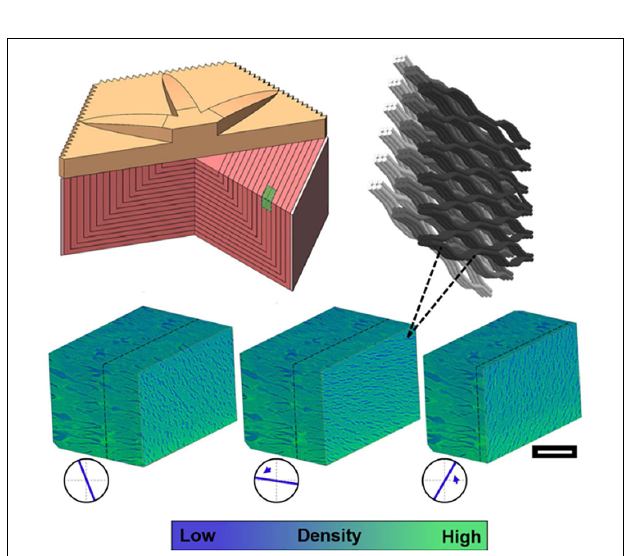
FIGURE 6 | Boxfish scale geometry and structure in high magnification (Garner et al.,